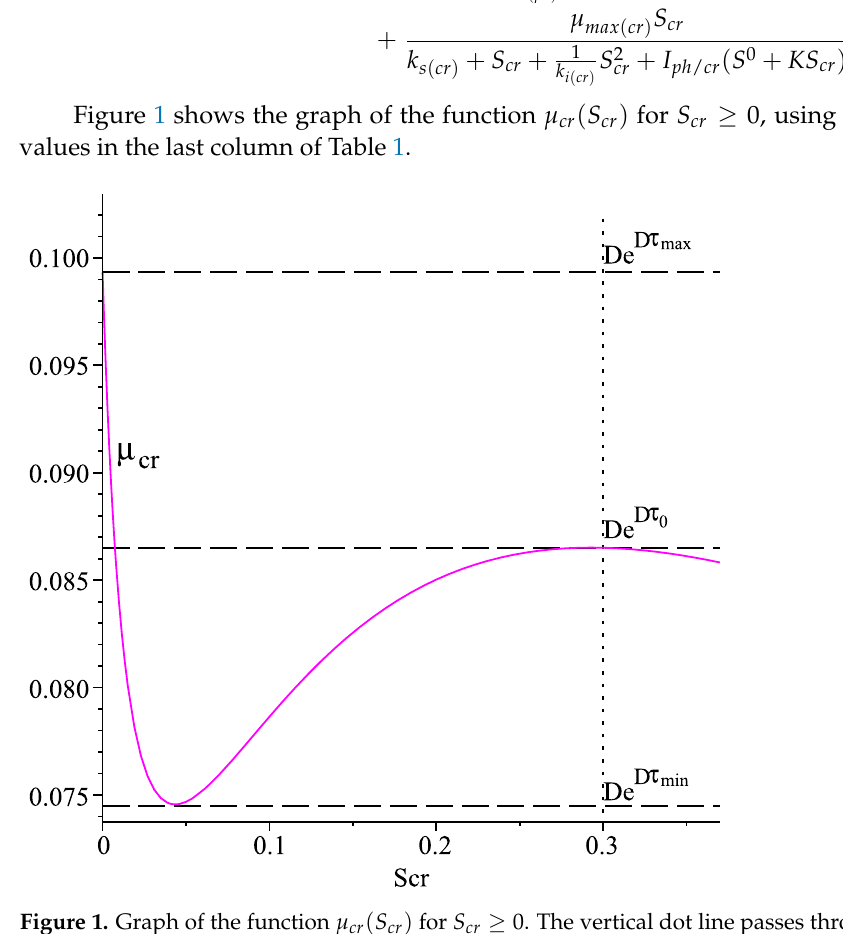
Figure 1. Graph of the function µ cr ( S cr ) for S cr ≥ 0. The vertical dot line passes through S 0 cr . From Equation (6), we learn that the steady state component with respect to S cr is the solution of the